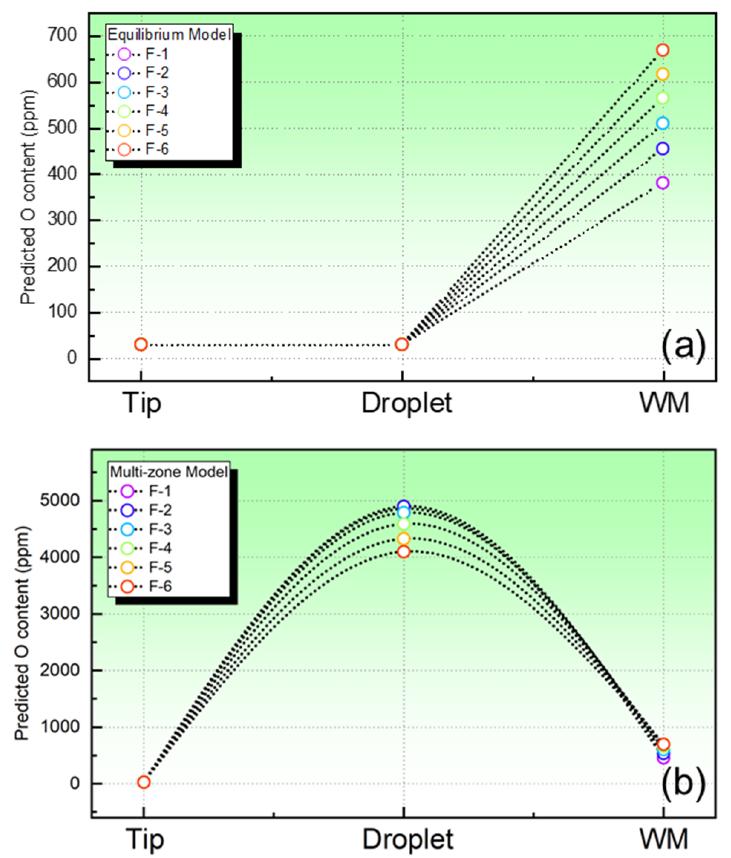
Figure 6. O content variation roadmaps in the metal predicted by both equilibrium and multi-zone models: ( a ) O content variation roadmap predicted by the equilibrium mode; ( b ) O content variation roadmap predicted by the multi-zone model.